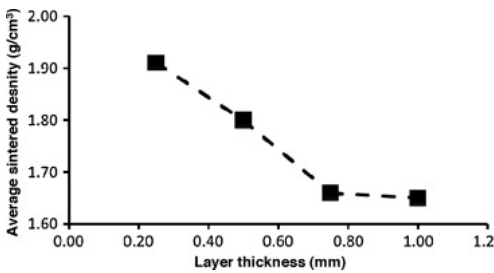
Figure 19. Variation of the density of SLS processed Al-12Si powder (45–75 µm) with layer thickness at fixed laser power (240 W), scanning rate (120 mm/s) and scan spacing (0.1 mm) [133]. Copyright 2010. Adapted with permission from Elsevier Science Ltd. under the license number—4803711190793 (Figure 5 [133]), dated 7 April 2020.